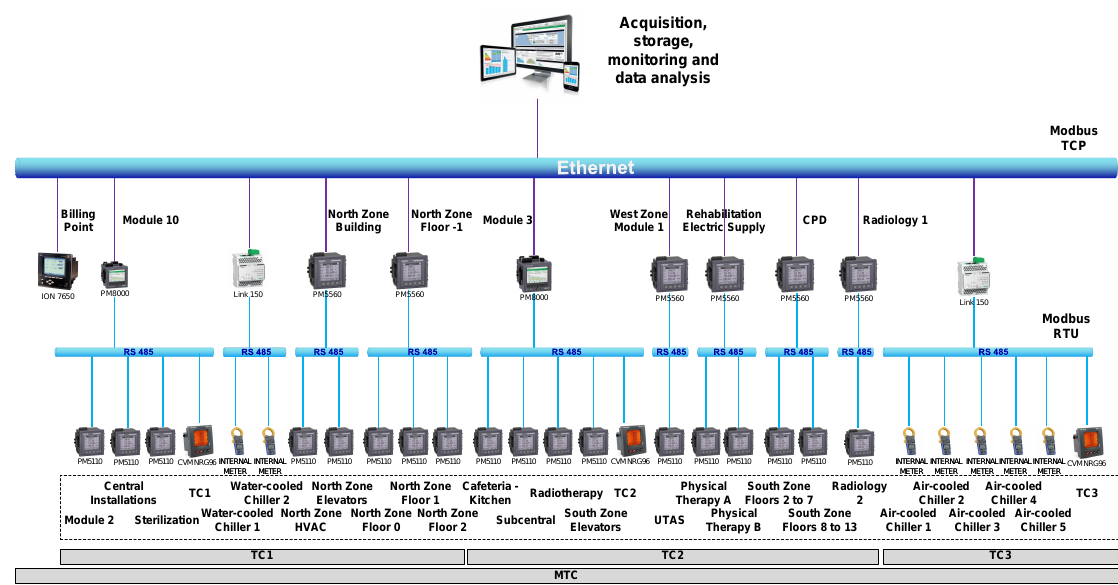
Figure 3. Submetering communication network.